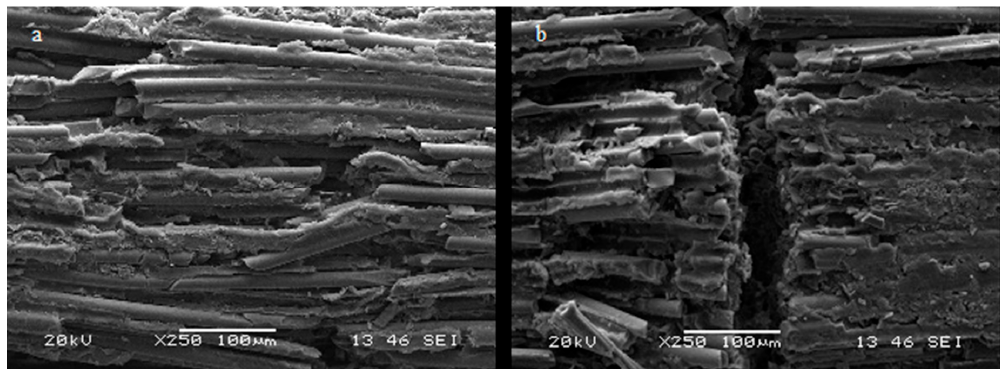
Figure 4. ( a ) Group 1: fracture line: oblique direction of fracture rim, ( b ) Group 0: the fracture direction is perpendicular to the post long axis.